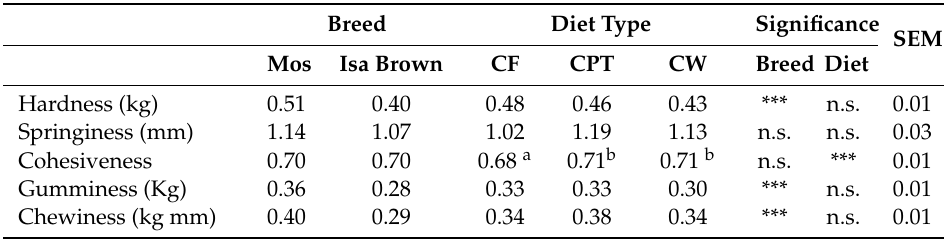
Table 4. E ff ect of breed (Mos vs. Isa Brown) and diet type (CF, CPT and CW) on textural parameters of